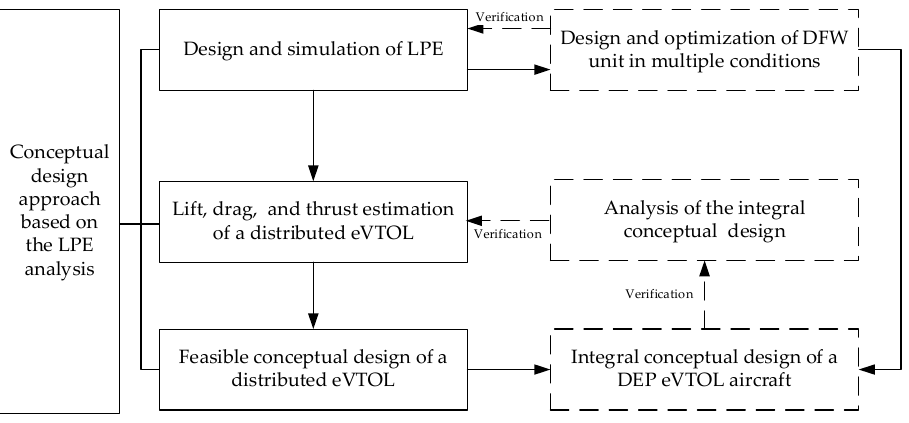
Figure 24. The flow chart of the investigation on the novel conceptual design approach.